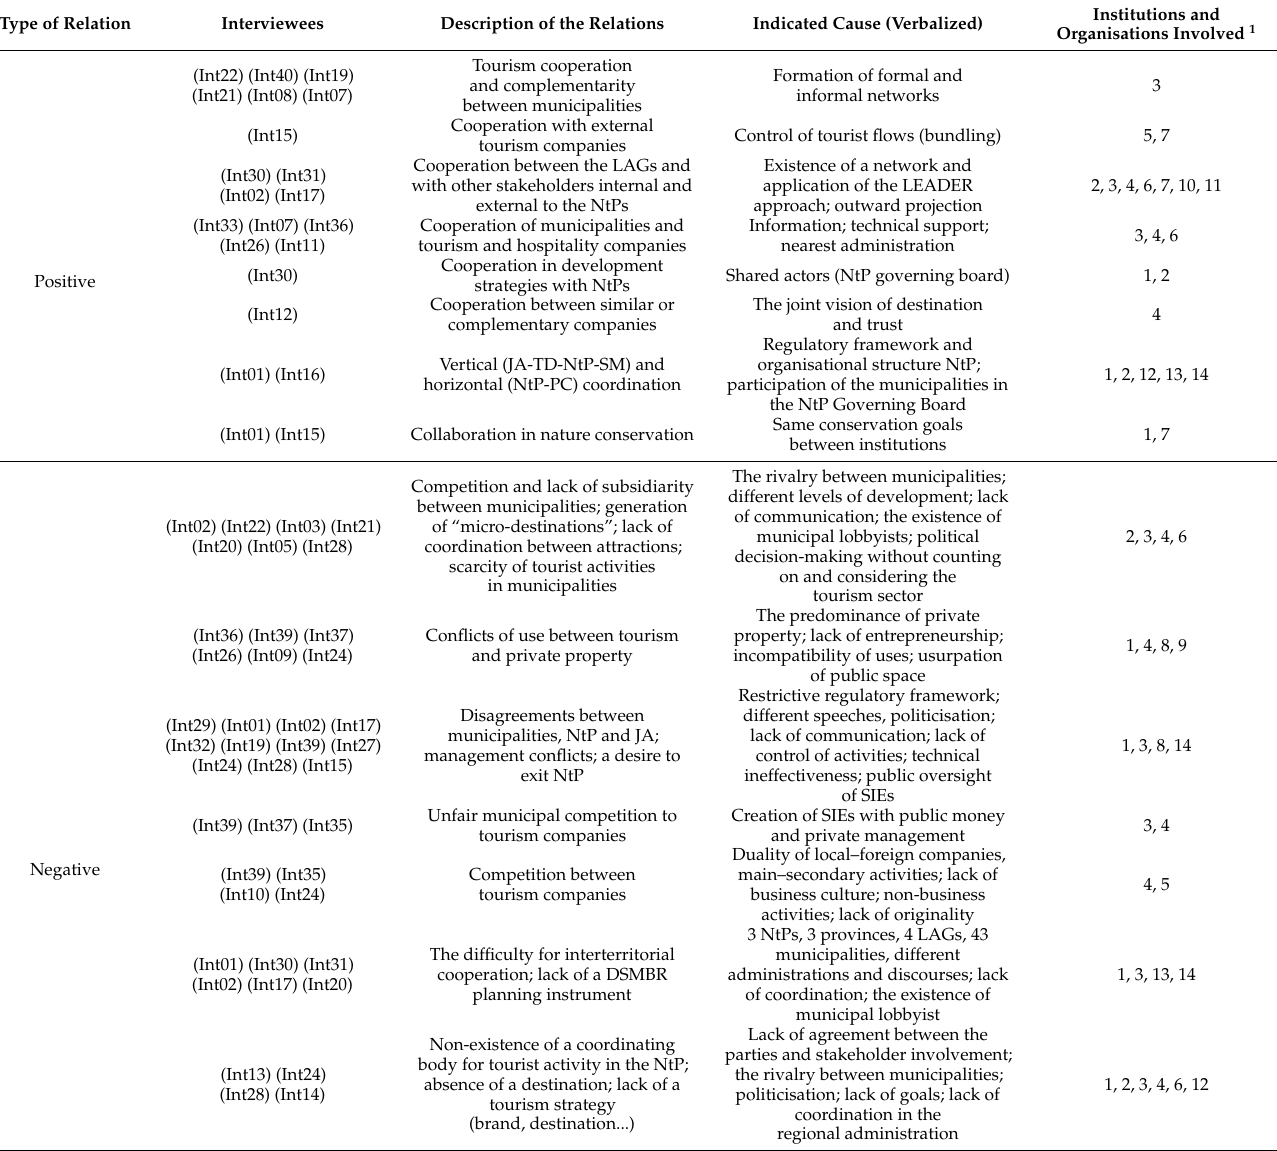
Table 3. Relations between stakeholders and the indicated